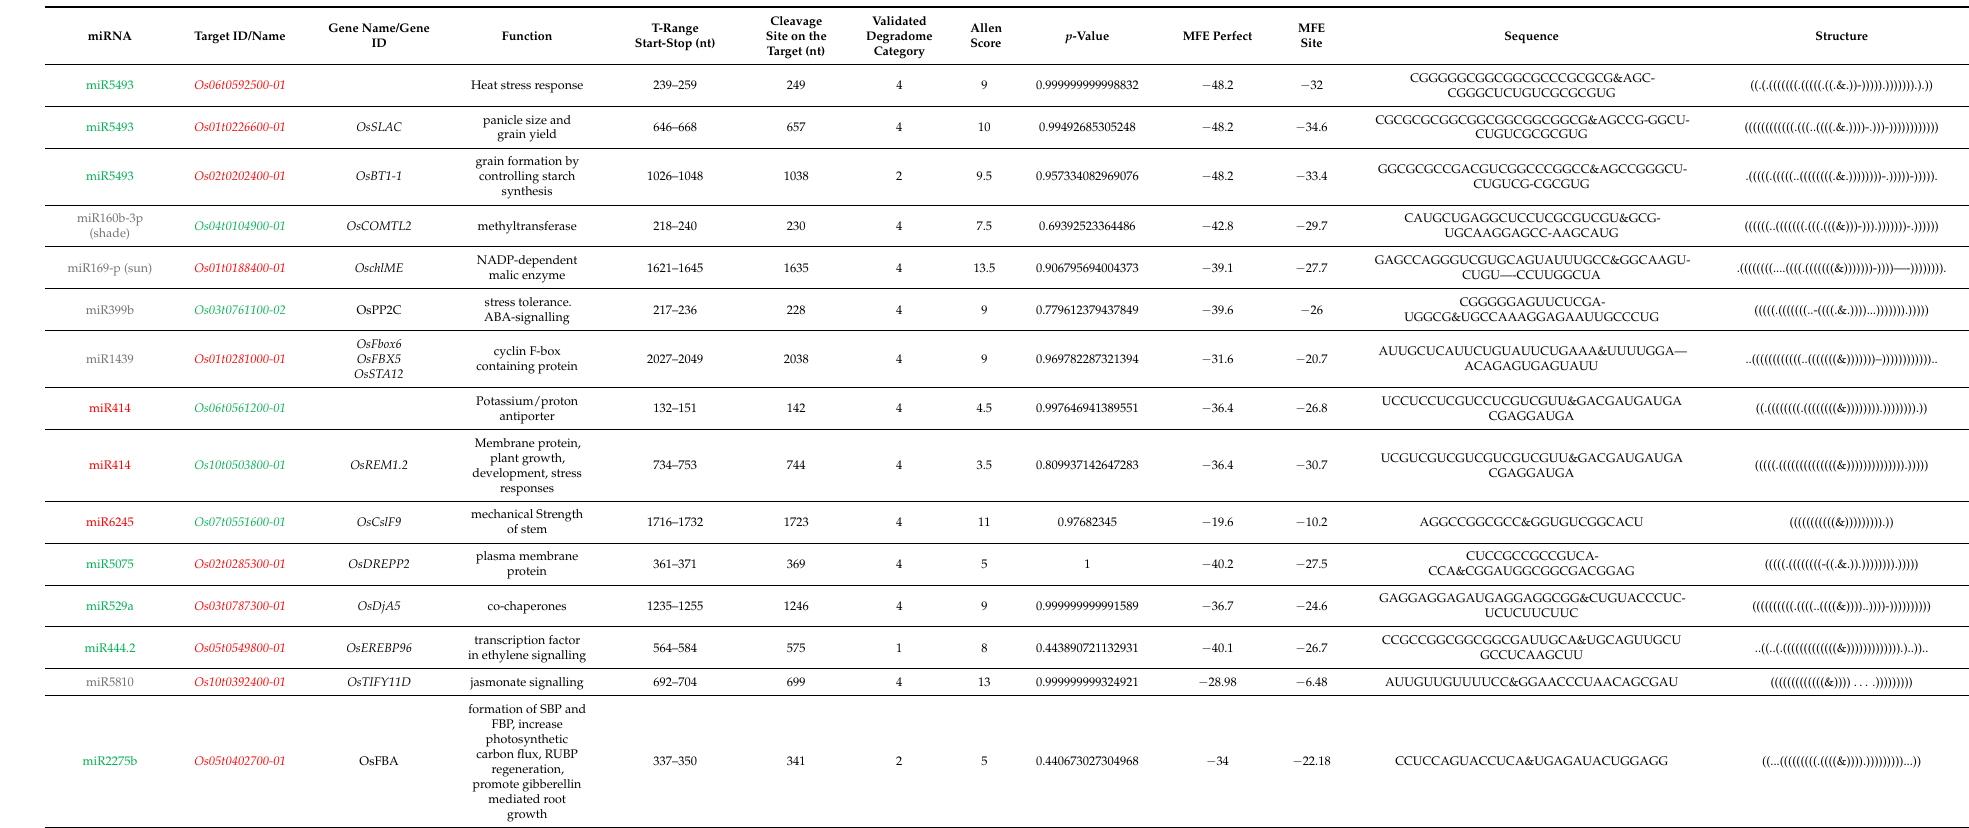
Table 1. Tabular list of miRNAs and their respective targets identified in this study. These miRNA–target pairs may play significant roles in prolonged shade tolerance in Swarnaprabha. In the miRNA category, the red color indicates upregulated, the green color indicates downregulated, and the grey color indicates neutrally regulated or uniquely expressed miRNAs. Unique expression is indicated within brackets. T-Range: Target range (TStart: alignment start position with transcript; TStop: alignment end position with transcript). Allen score: penalty score calculated per the work of Allen et al. (2005) [58]; MFESite: minimum free energy for alignment in question; MFEPerfect: minimum free energy for perfectly matched site; structure: stable binding of miR and target is accompanied with a decrease in free energy. Aligned secondary structure sequence: aligned